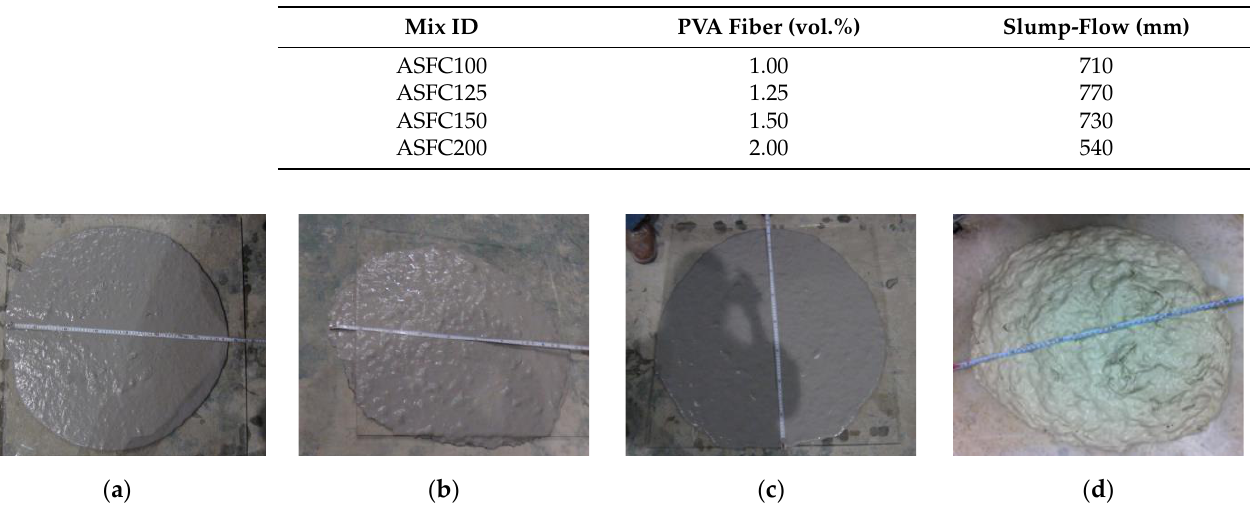
( b ) Figure 2. Slump-flow test: ( a ) Test setup; ( b ) Cube specimen.